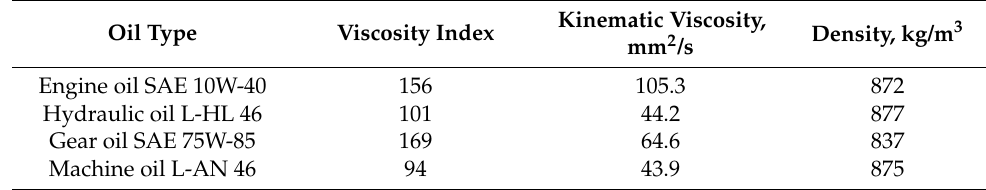
Table 1. Basic properties of oils used. Oil Type Viscosity Index